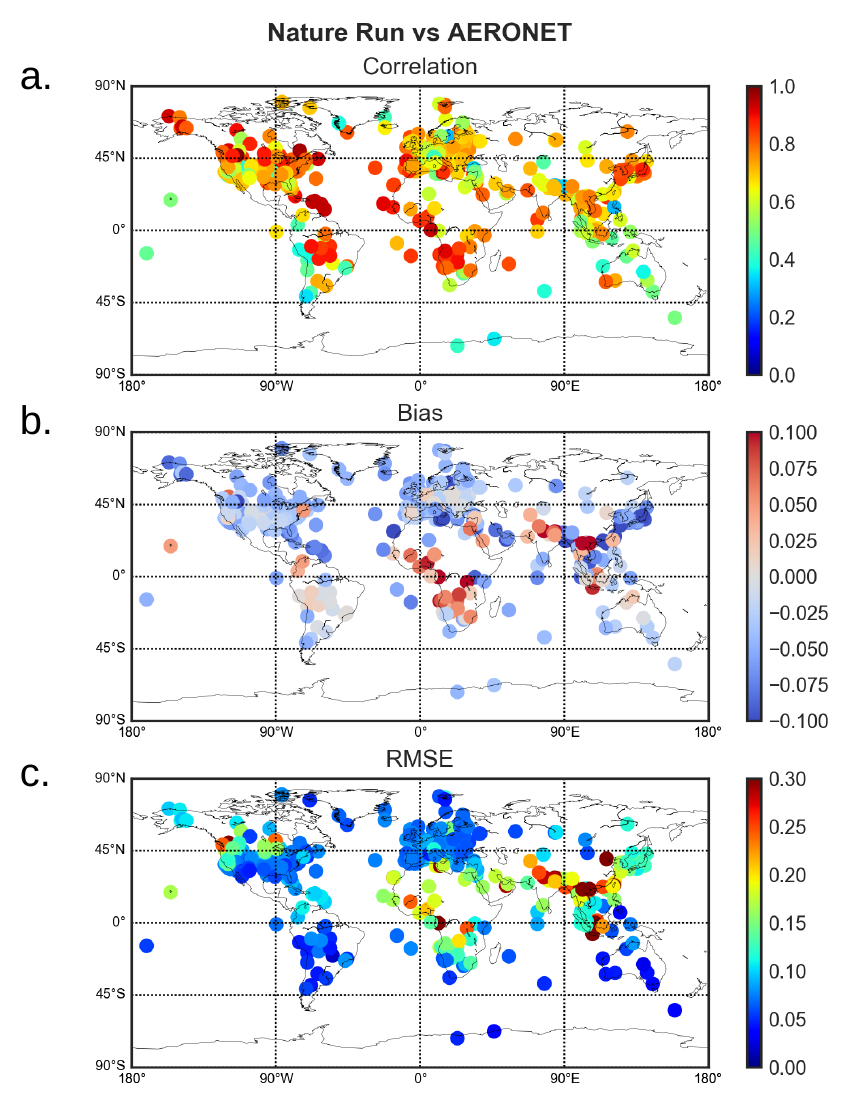
Figure 2. Maps of comparison between the NR and the AERONET of in situ observations in terms of AOD over the globe, from 1 February to 31 September 2018. Statistics are performed in terms of ( a ): correlation, ( b ): bias, and ( c ):